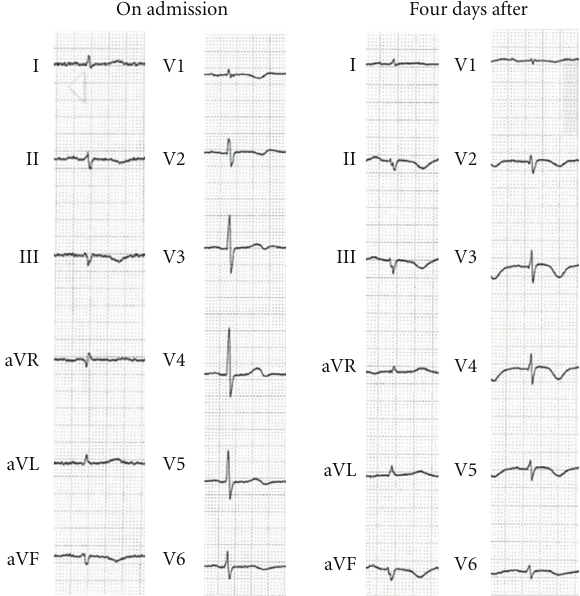
Figure 1: Electrocardiogram changes on admission and four days later while su ff ering from cardiomyopathy. New inverted T waves were present in the V3-4 leads.